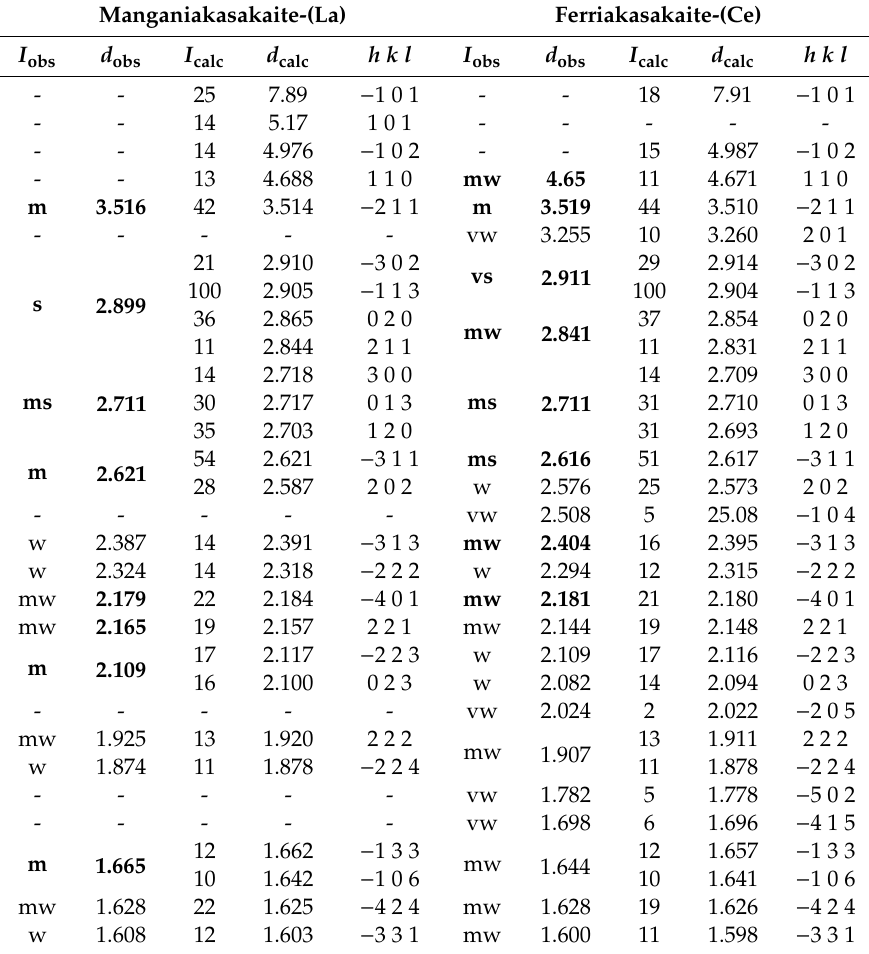
Table 3. Observed and calculated X-ray powder di ff raction data for manganiakasakaite-(La) and ferriakasakaite-(Ce).